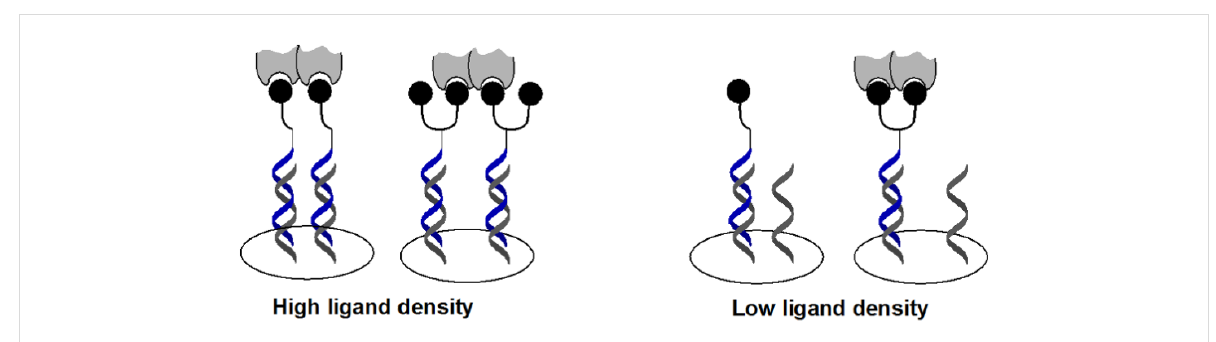
Figure 9: General scheme of the 10,000 member PNA-encoded glycoconjugate library.